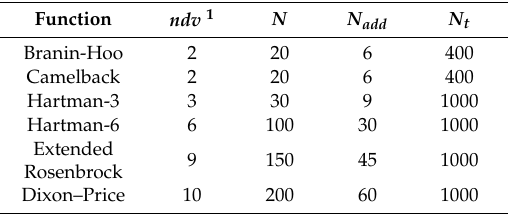
Table 1. Summary specifications for numerical